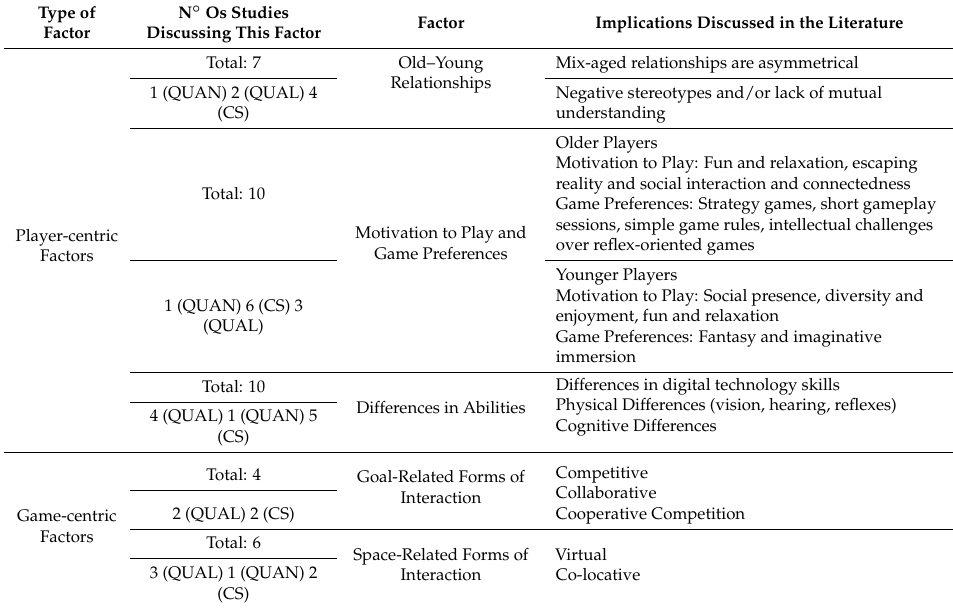
Table 3. Factors to Consider for Intergenerational Digital Game Design (QUAL: qualitative, QUAN: quantitative, CS: case